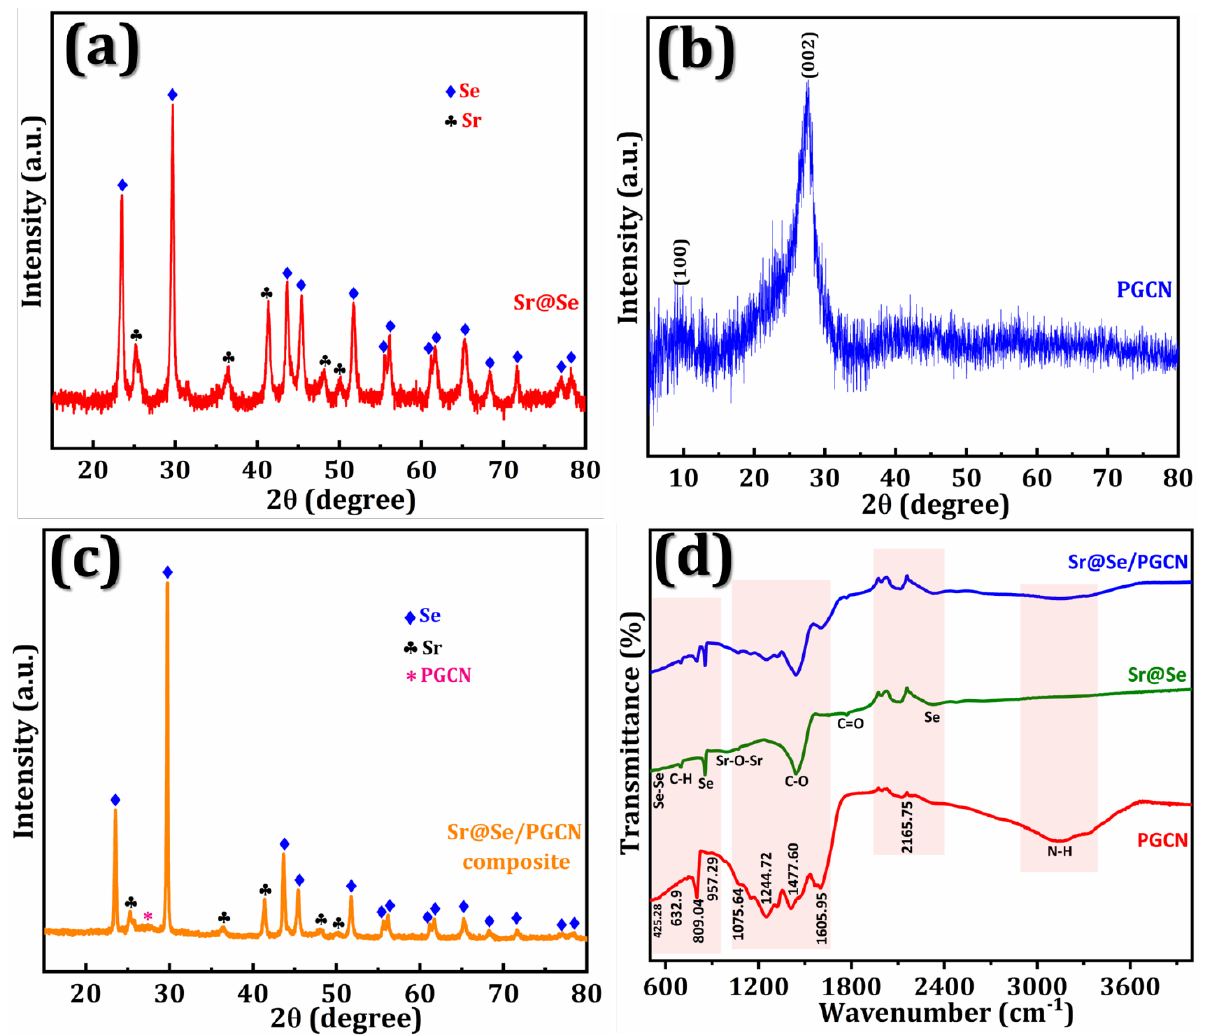
Figure 1. ( a ) XRD spectrum of Sr@Se, ( b ) PGCN, ( c ) Sr@Se/PGCN composite, and ( d ) FT-IR spectra of Sr@Se, PGCN, and Sr@Se/PGCN composite.